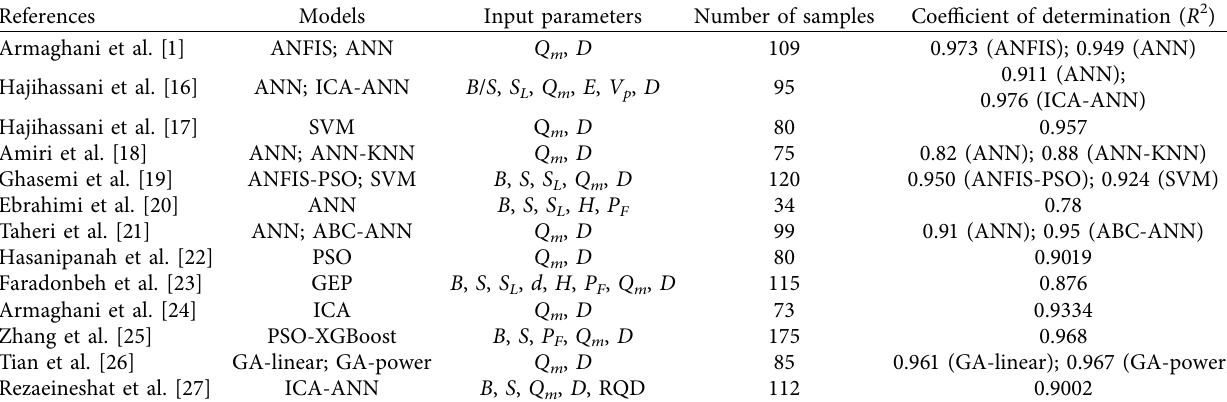
Table 1: Prediction of PPV by intelligent